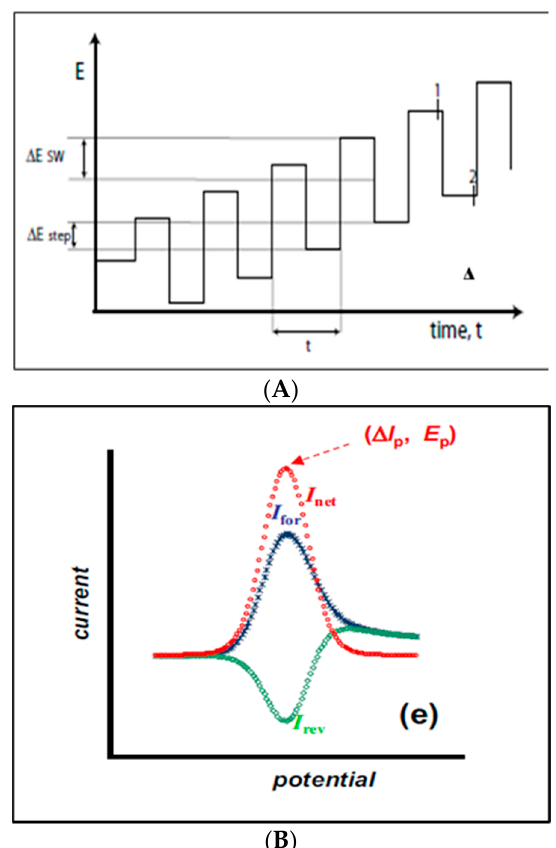
Figure 6. Square wave voltammetry showing ( A ) potential against time and ( B ) current against potential (Adapted from [104] copyright Elsevier, 2017).